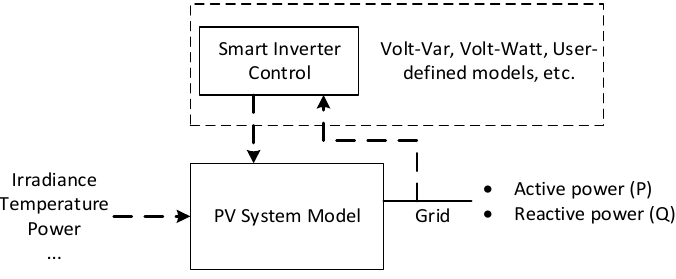
Figure 2. Simplified block diagram of OpenDSS model for PV system [33].